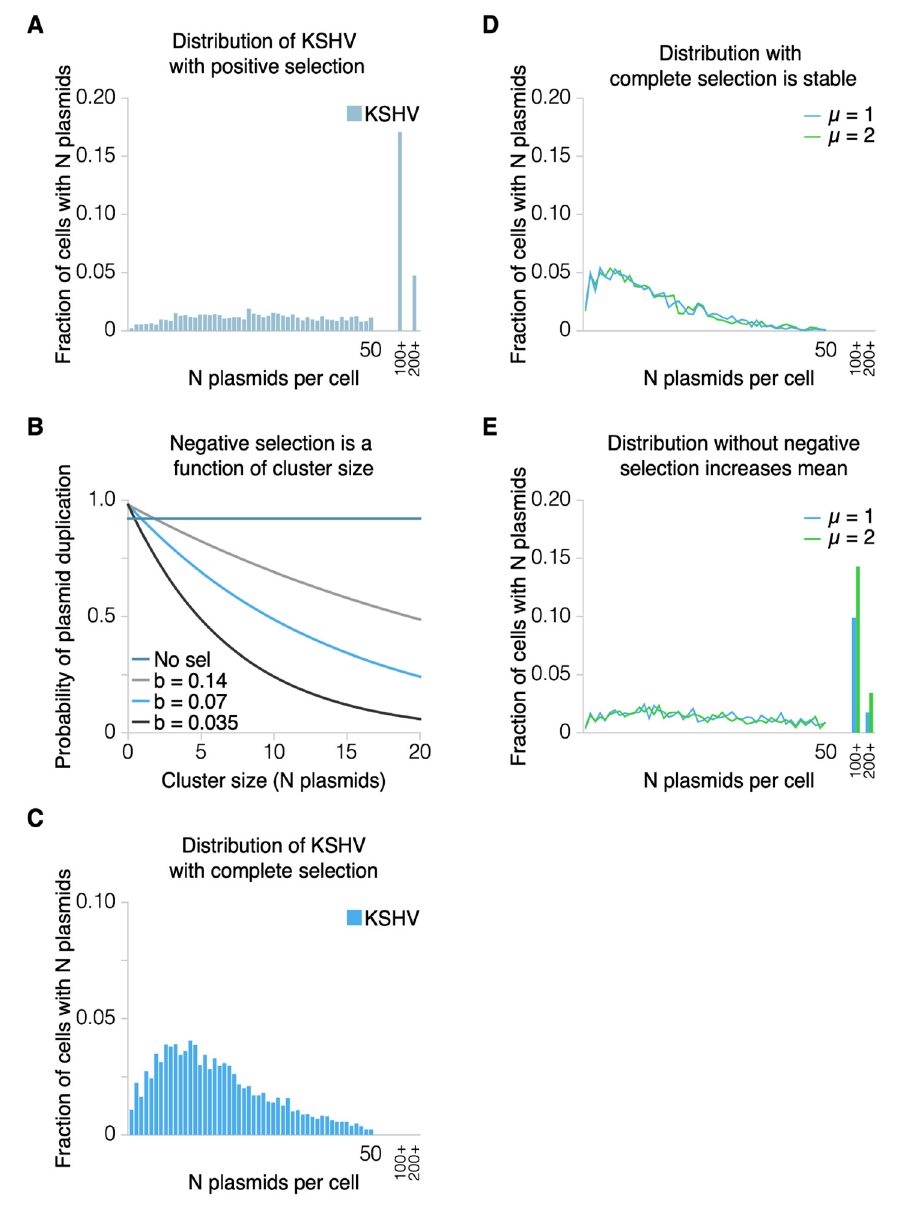
Figure 5. The distributions of KSHV with additional forms of selection are shown. ( A ) A distribution in the same form as Figure 4A, but now calculated with a term for positive selection. The positive selection coefficient and terms are identical to those for EBV, as shown in Figure 3B. Positive selection increases the fraction of cells with unrealistically high numbers of plasmids per cell. ( B ) To model more accurately the results from [16], negative selection was modeled as an exponential decay function describing the probability that any plasmid in a cluster is duplicated as a function of the cluster size. The function was in the form of F ( x ) = de − bx in which “ x ” is the size of the cluster; “ d ” is the default duplication probability; and “ b ” is a variable parameter, which we computationally varied and ultimately optimized to be 0.07. ( C ) A distribution in the same form as Figures 4A and 5A, but now calculated with both positive and negative selection. Note that negative selection